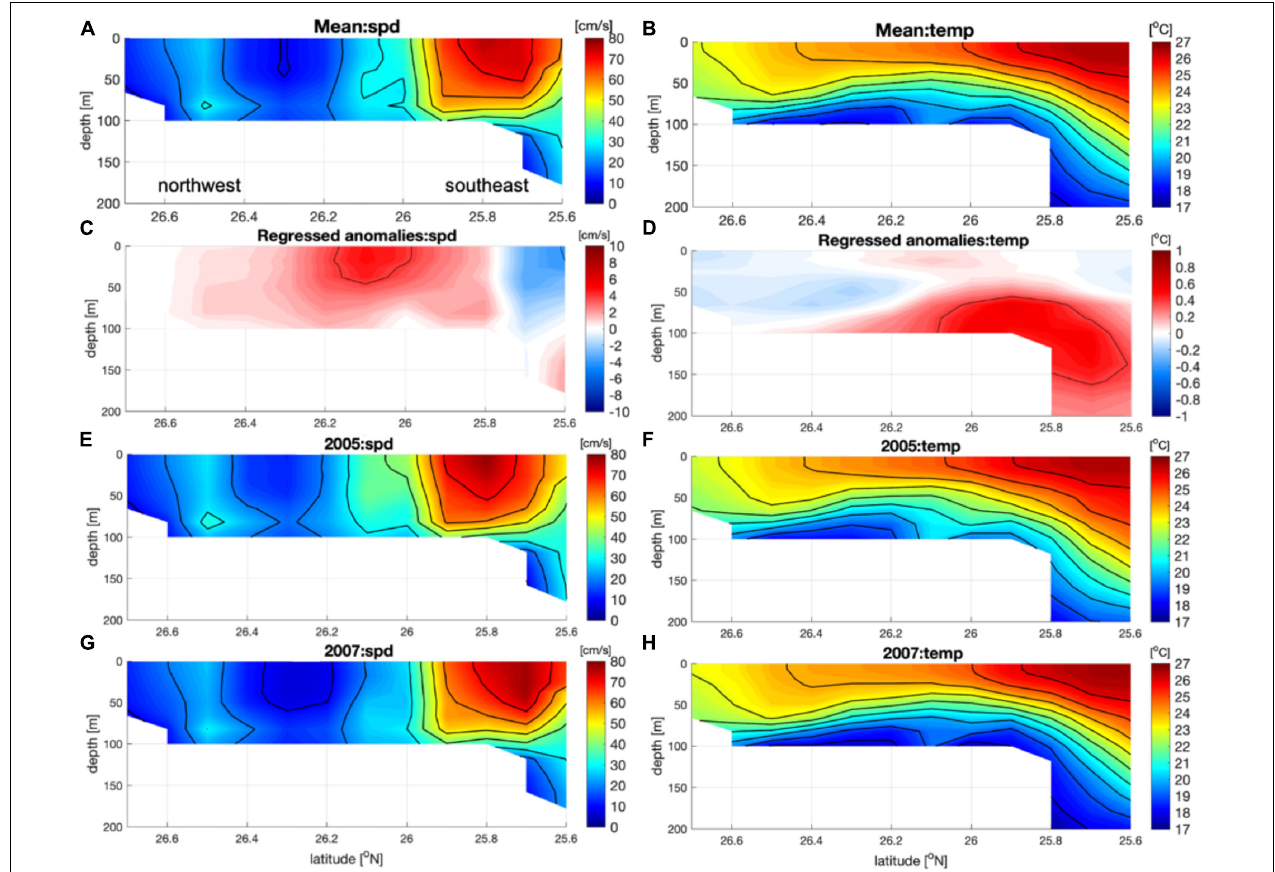
FIGURE 7 | Vertical sections (northwest to southeast) of the (A,B) mean and (C,D) regressed anomalies diagonally crossing the KSI domain: (A,C) current speed and (B,D) temperature. Panels (E–H) display current speed and temperature in 2005 (when the KSI was strong) and 2007 (when the KSI was weak), respectively. Black contours in panels (C,D) denote 4 cm/s and 0.4 ◦ ,